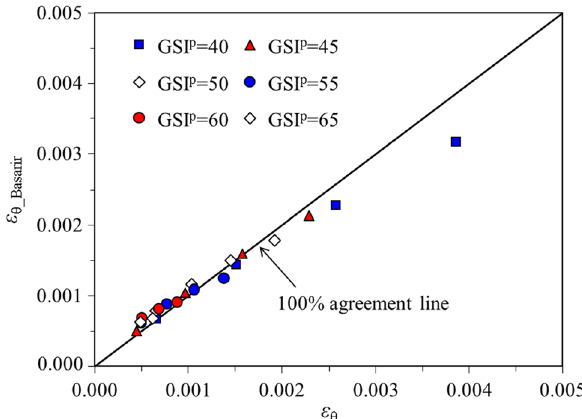
Figure 7. Comparison between ε θ and ε θ_Basarir